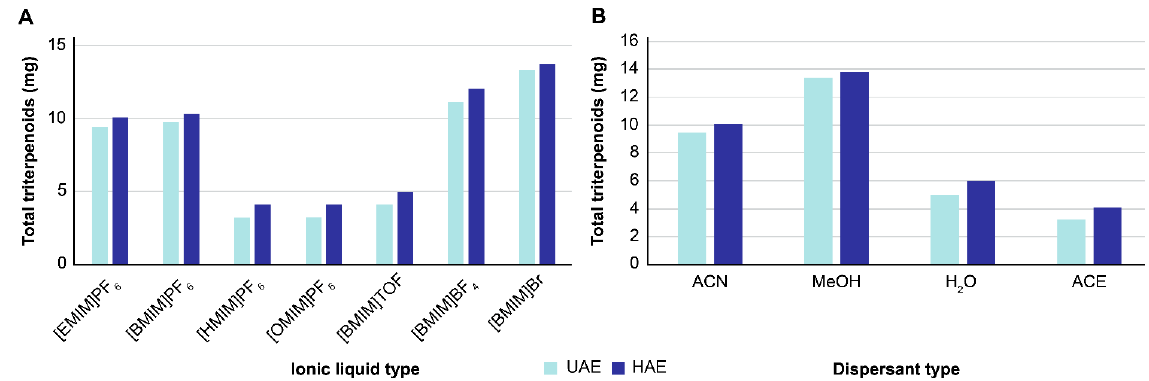
Figure 2. ( A ) Effect of different ionic liquid (IL)-methanol extracts on total triterpenoids. ( B ) Effect of different dispersants on total triterpenoids, with IL = [BMIM] Br.